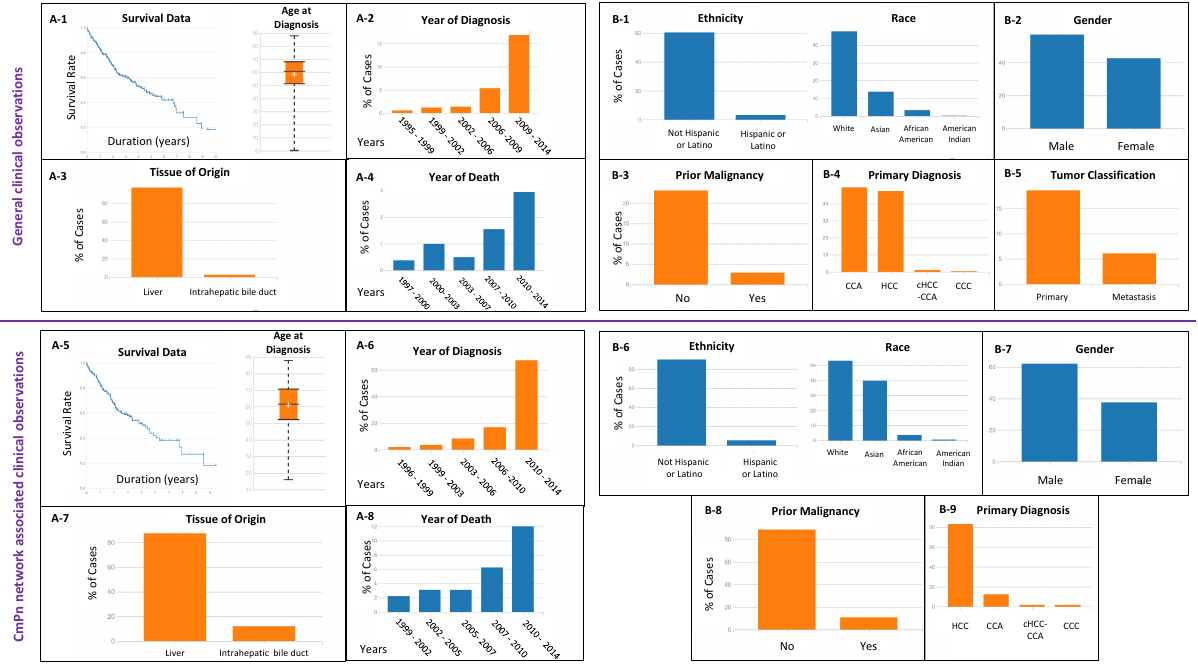
increase in the number of cases originating in the intrahepatic bile ducts for patients with differential expression of CmPn members (~12%) compared to patients without CmPn alterations (~3%).